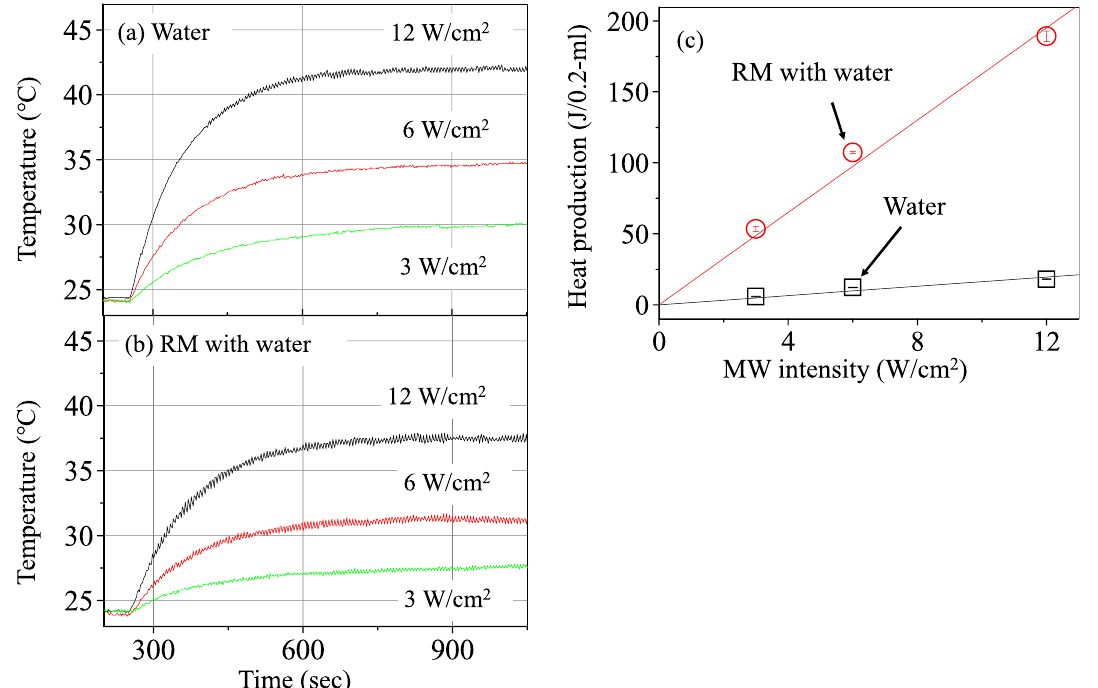
Figure 2. Real-time changes in the temperatures of samples of water ( a ) and RM solution with water ( b ) at three MW intensities, where black, red, and green curves are the results at MW intensities of 3, 6, and 12 (W/ cm 2 ), respectively. ( c ) Heat productions (J/0.2-ml water) due to liquid water (black squares) and to water in RM solution (red circles) as a function of MW intensity, where the mean values with standard deviations (error bars) are shown, obtained from the measurements made three times. The straight lines (red for RM with water and black for water) were gained by least-squares fitting to the data with coefficients of determination of 0.98 for RM solution and of 0.88 for